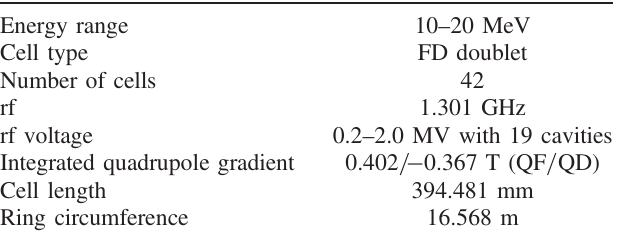
TABLE I. Main parameters of the EMMA NS-FFAG. Energy range